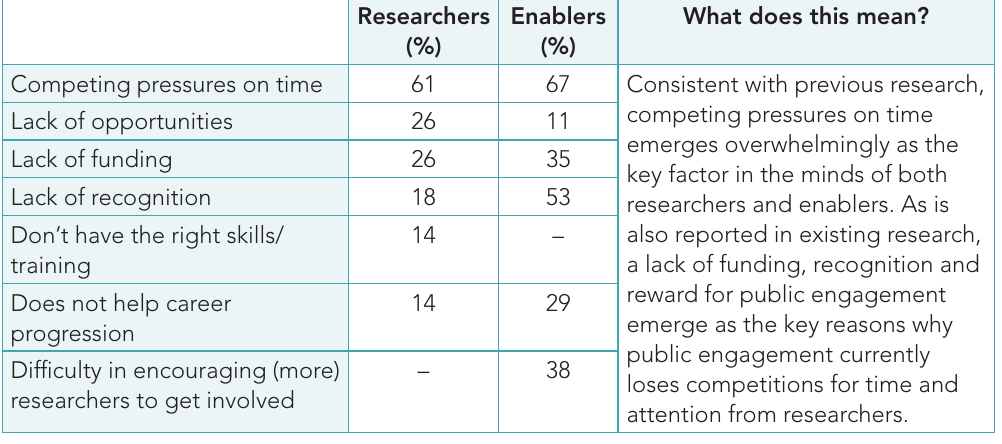
Table 8: Main constraints on researchers’ participation (above 10% only) Competing pressures on time 61 67 Consistent with previous research,